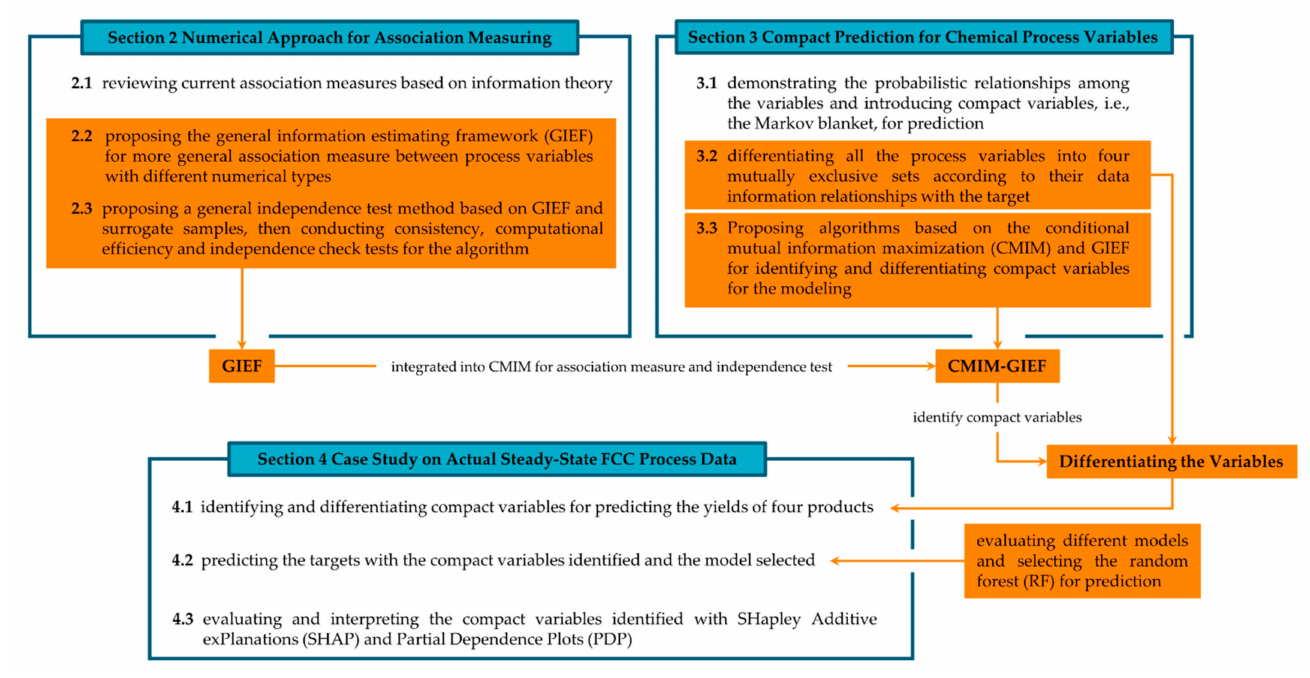
Figure 1. An overall flow chart of the rest part of this